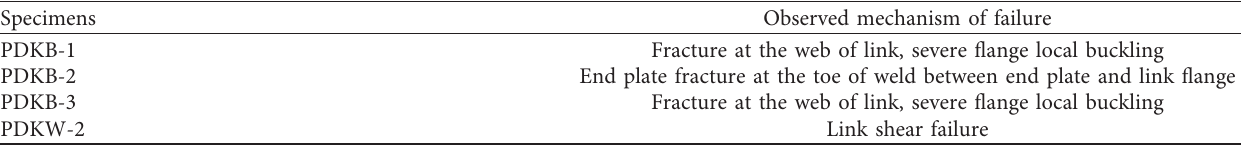
Table 8: Mechanism of failure of different specimens.